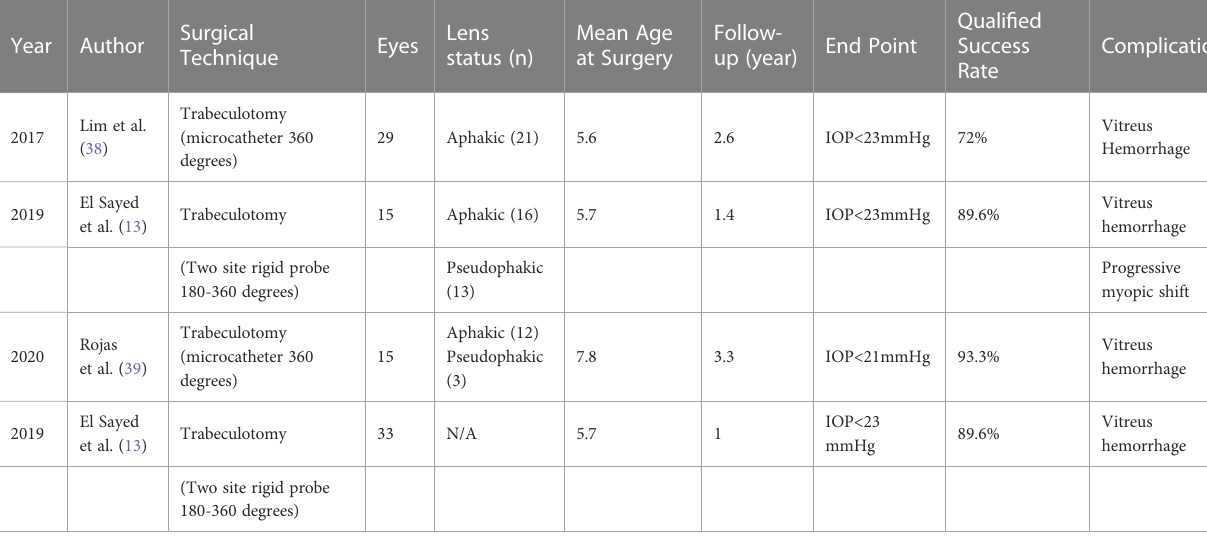
TABLE 3 Studies investigating angle surgery in pediatric glaucoma following cataract